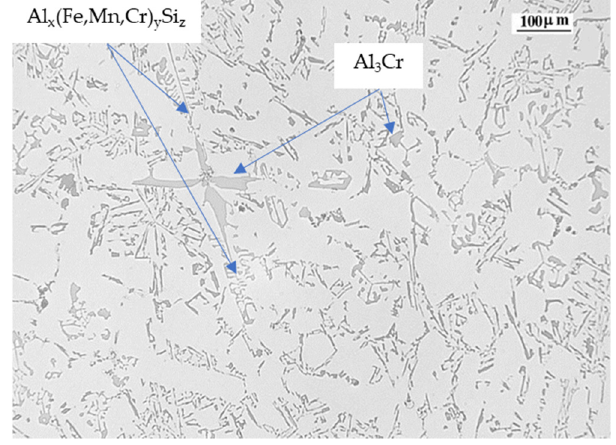
Figure 12. Alloy 3 micrography showing the Al 3 Cr and Al x (Fe,Mn,Cr) y Si z phases.